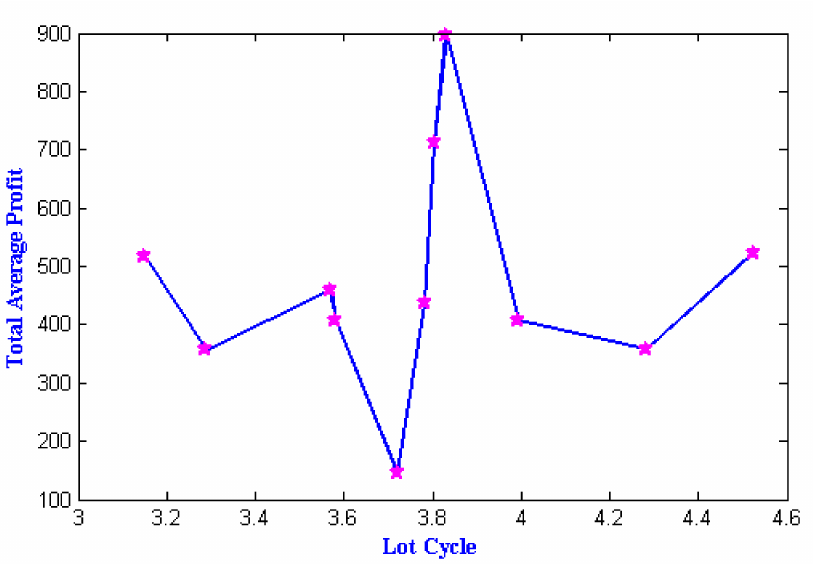
Figure 7. Variation of optimum values of the objective function total average profit ( TAP ∗ ) with respect to the decision variable lot cycle ( Q ∗ ) for the model with